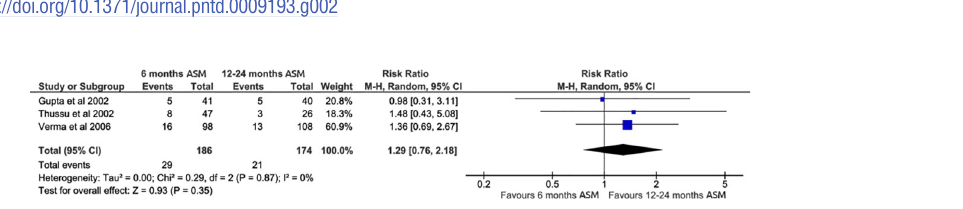
Fig 3. Forest plot. 6 months ASM versus 12–24 months ASM. Outcome: seizure recurrence.